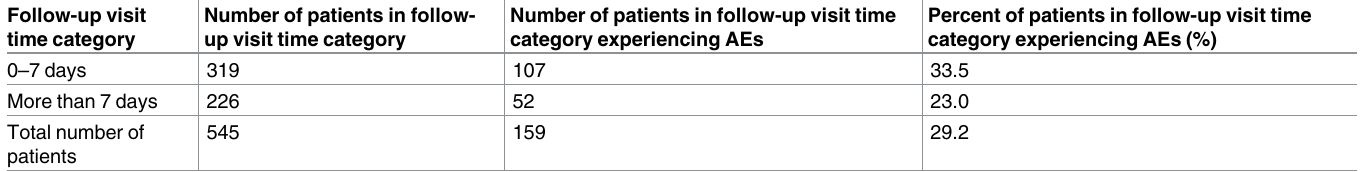
Table 2. Unadjusted association between post-discharge adverseevents and timely post-discharge follow-up visits (N = 545). Follow-up visit time category